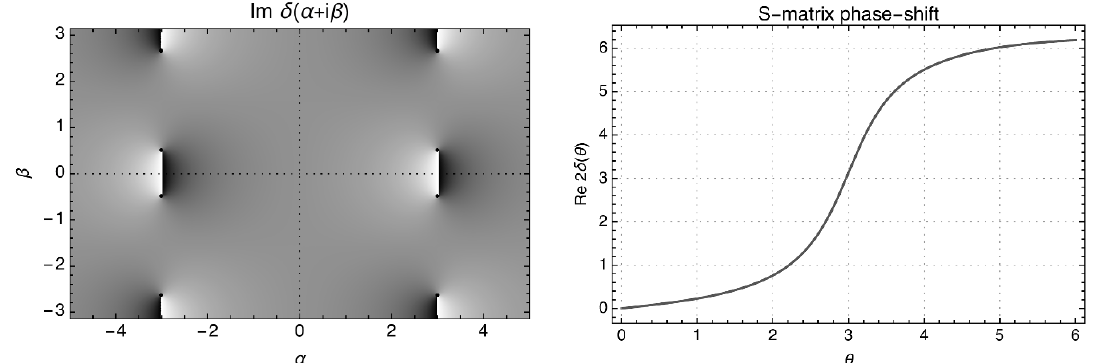
Figure 2 . Left : section of the complex plane of the phase of eq. (3.5), the lines (cid:14) ( i(cid:25) ) (cid:24) (cid:14) ( (cid:0) i(cid:25) ) should be indenti(cid:12)ed. Right : phase-shift of eq. (3.5) localized around the position of the branch points generated by the zeros and poles of S ex ( (cid:18)